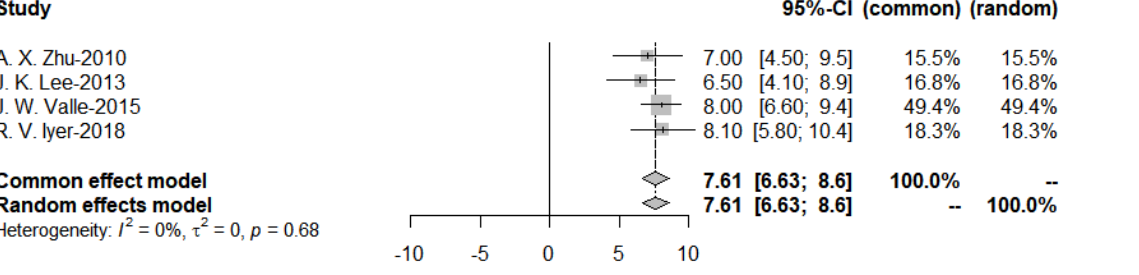
Figure 11. Progression ‐ Free ‐ Survival of EGFR targeted therapies.